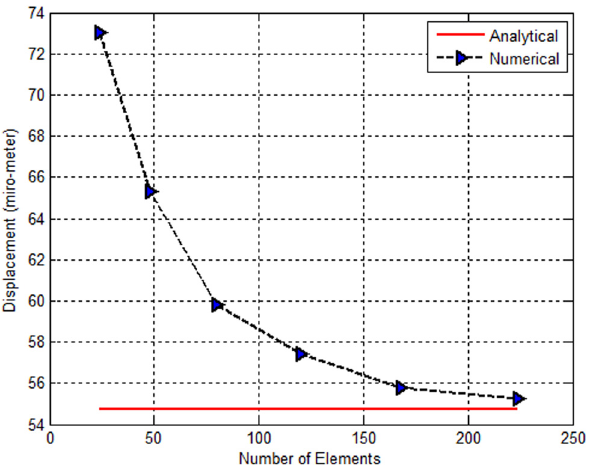
Figure 4: Mid - surface displacement – convergence test.